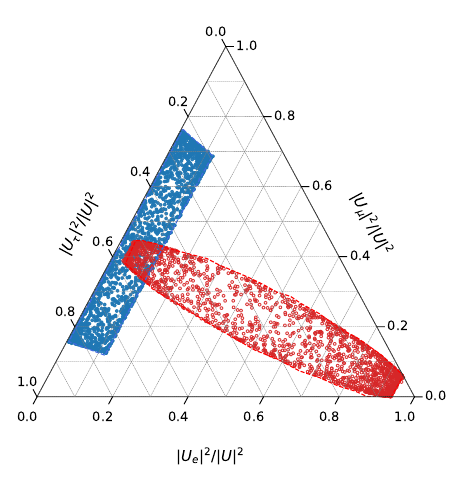
Figure 13 . Points of the numerical scan with successful baryogenesis within the sensitivity region of SHiP and FCC for NH (blue) and IH